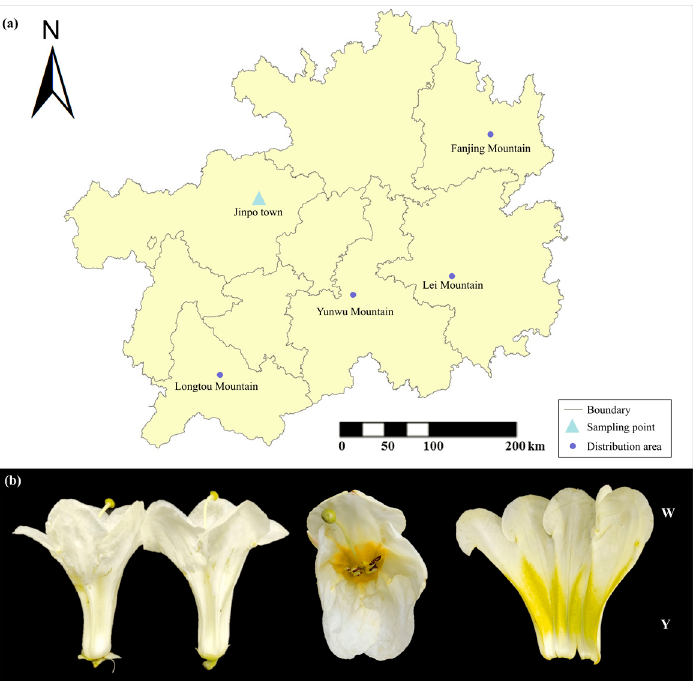
Figure 2. ( a ) Distribution of R. liliiflorum in Guizhou Province, China; ( b ) Pictures of R. liliiflorum flowers and white (W) vs. yellow (Y) parts.